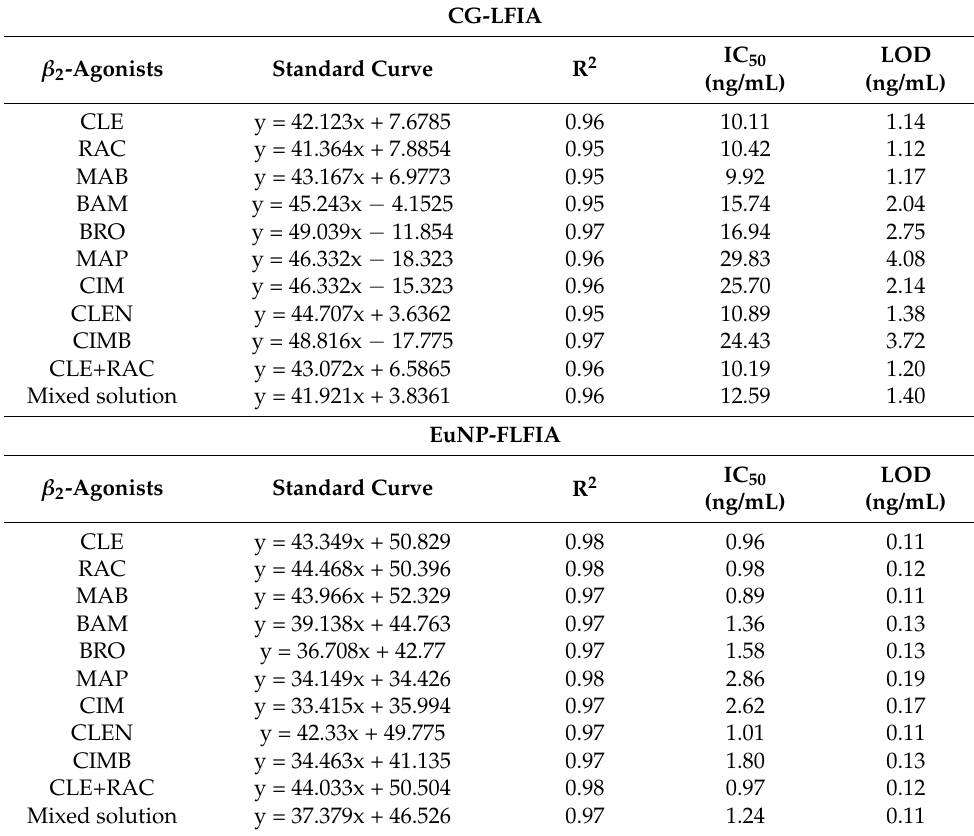
Table 1. Standard curve equations for the analysis of β 2 -agonists using CG-LFIA and EuNP-FLFIA.